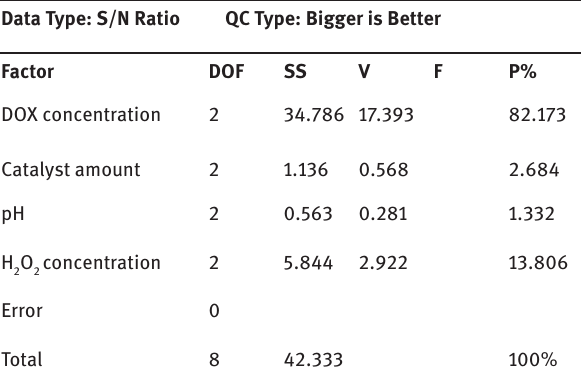
O /SAPO-34 (A) and the catalyst 2 3